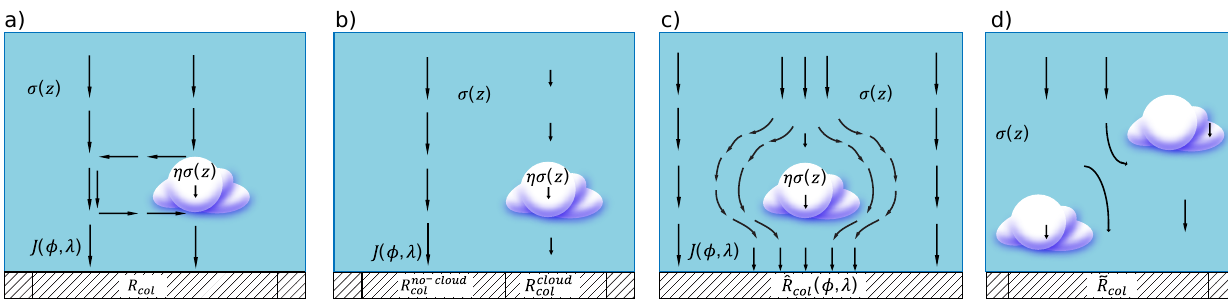
Figure 1. Schematics of cloud modifications of conductivity and column resistance. Arrows denote current direction and the current density magnitude in a qualitative sense. Single cloud, with current mainly flowing around the cloud as assumed in the small cloud approximation (a) . Single cloud, only allowing for vertical currents as assumed in the large cloud approximation (b) . Current divergence/convergence around the cloud, and “effective column resistance” as a function of latitude and longitude, employed for the current continuity approach (c) . Model grid column with cloud fraction and current continuity approach column resistance e R col (d)